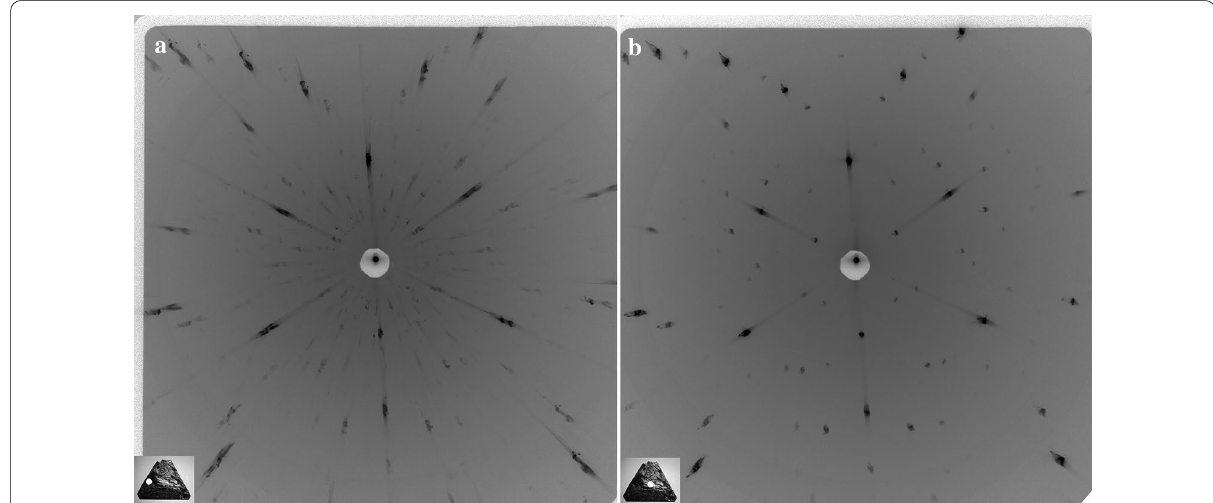
Fig. 1 X-ray transmission Laue patterns obtained from: a peripheral area of the BDD plate and b central area of the BDD plate. The radial streaks in Laue patterns are caused by the diamond crystal lattice